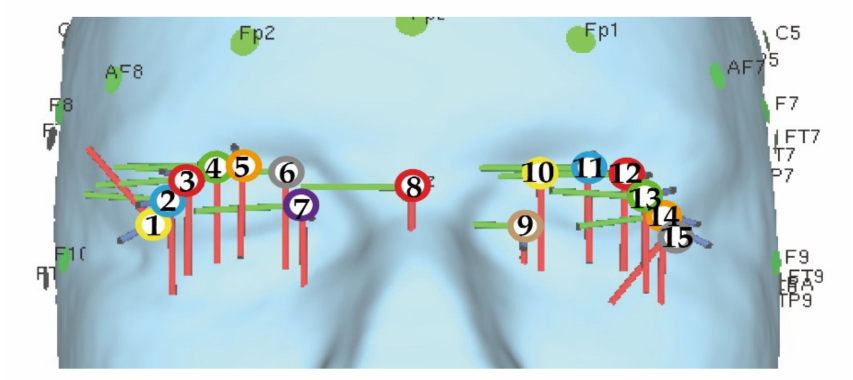
Figure 5. The points on the eyeball surface for observing the transition of the electric field value